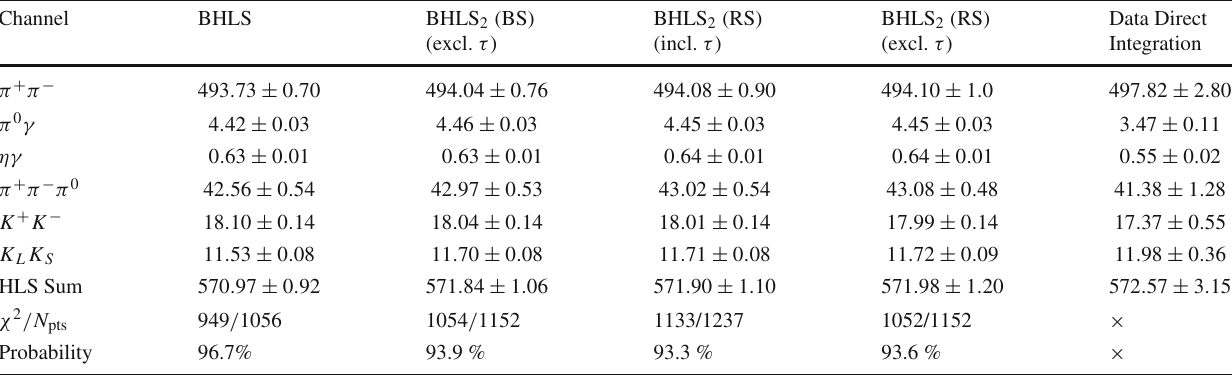
Table 7 HLS contributions to 10 10 × a HVP − LO integrated up to 1.05 GeV, including FSR. The first data column displays the results using the former BHLS [25,27] and, the second one, those derived from the Basic Solution for BHLS 2 , the τ decay data being discarded. The next two data columns refer to the results obtained using the Reference Solution